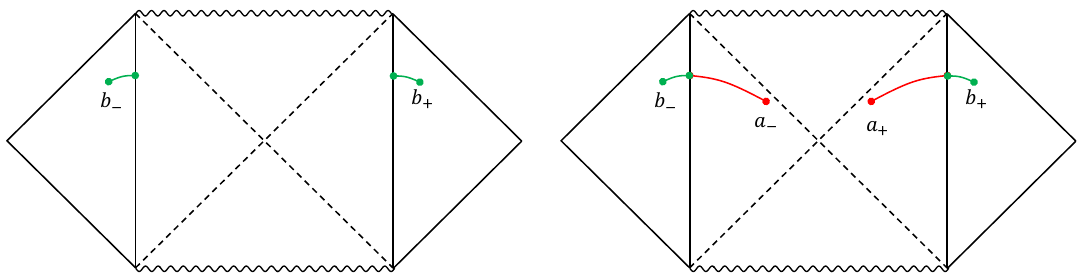
Figure 2 . In the case of black holes in AdS spacetime, an auxiliary system is introduced outside the boundary of AdS spacetime. The region of the black hole is put in the auxiliary flat spacetime (left). It is extended into the AdS spacetime due to gravitational effects, and ends at the quantum extremal surface after the Page time (right). Before the Page time, it continues to the region in the other side of the event horizon. For the entanglement entropy of a region only in one of the two auxiliary flat spacetime, the region in the AdS spacetime always ends at the extremal